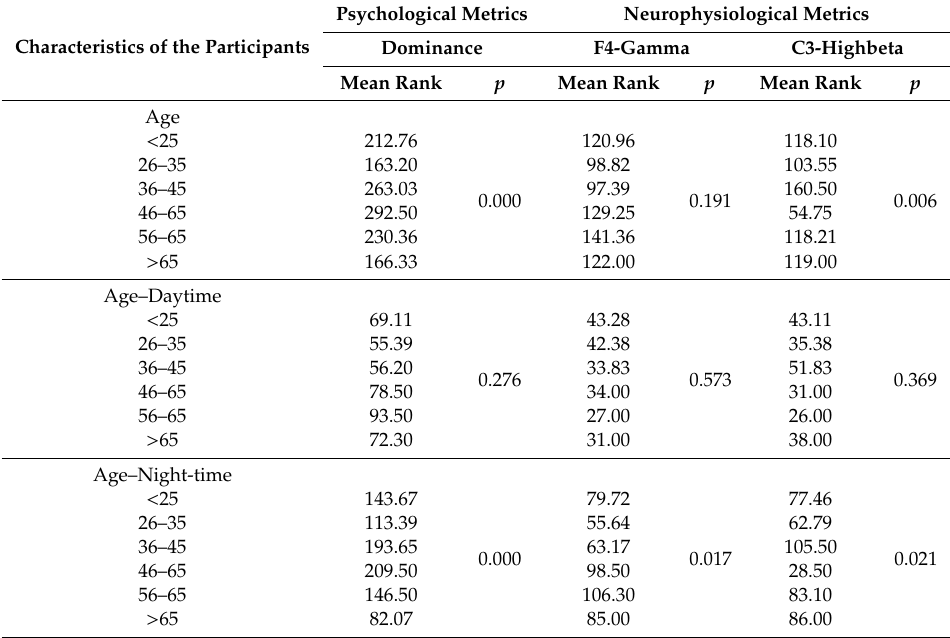
Kruskal-Wallis test for the di ff erences in the mean ranks of the psychological and neurophysiological metrics based on the age of the participants (significance level p <